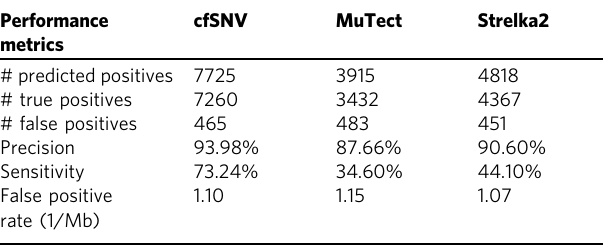
In the simulated dataset, 9912 mutations were inserted in silico as ground truth somatic